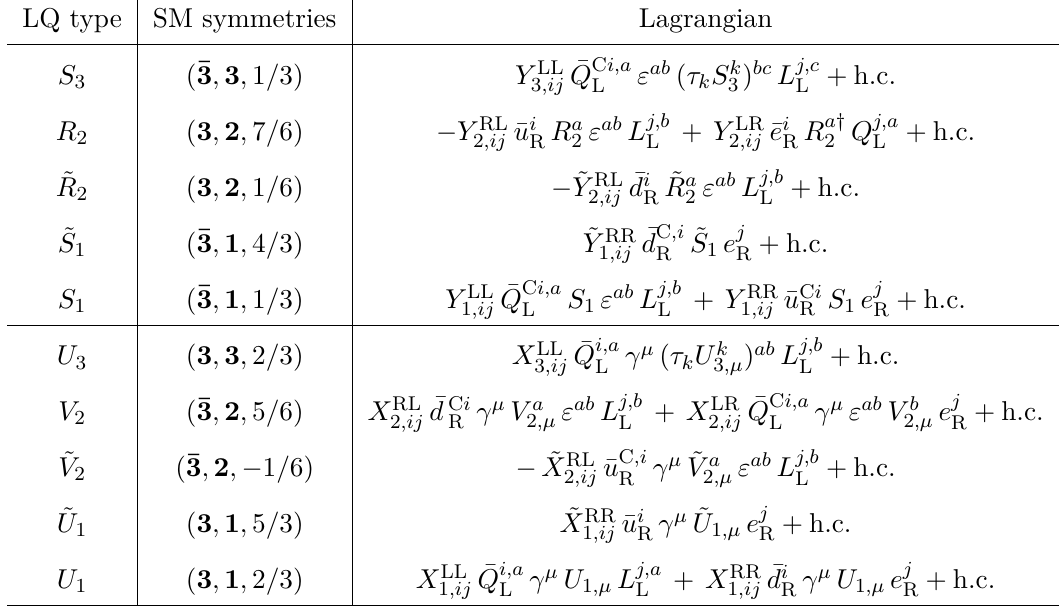
Table 1. Classification of leptoquarks based on the representations of matter fields under the SM gauge group SU (3) SU (2) U (1) , and related Lagrangians representing the interactions of C × L × Y leptoquarks with SM quarks and leptons. Only terms potentially responsible for CLFV are shown, and all these terms then constitute the L Lagrangian. The Yukawa-like couplings Y χ 1 χ 2 and LQ–SM d,ij , d = 1 , 2 , 3 , are dimensionless. The hypercharge Y is related to the electric charge Q via Q = X χ 1 χ 2 d,ij I 3 + Y , with I 3 staying for the third SU(2) L generator, the specific realisation of which, as mentioned in the main text, depends on the corresponding leptoquark representation. As is customary, Q and L L L stand for the left-handed quark and lepton SU(2) doublets, u R ( d R ) and e R are the up(down)- type quark and lepton right-handed SU(2) singlets, respectively. Finally, τ are the Pauli matrices k ( { τ = 2 δ ) and ε stands for the Levi-Civita symbol in two dimensions ( ε = iτ ). The letters k , τ l } kl 1 2 2 i, j = 1 , 2 , 3 denote flavour indices, while a, b, c = 1 , 2 are SU(2)-gauge-group-related